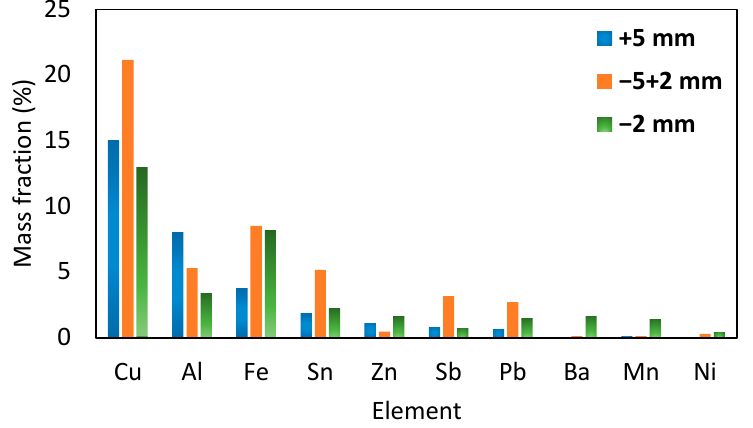
Figure 4. Content of the main metals present in the samples.